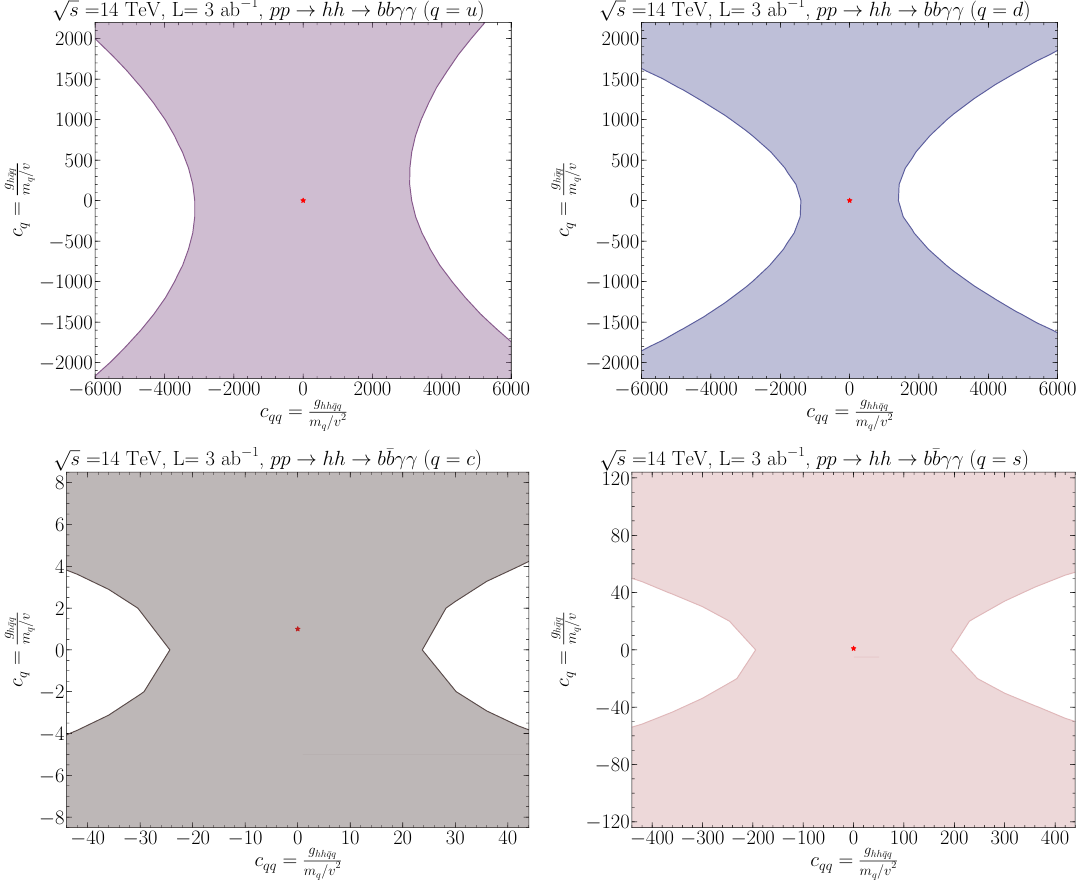
Figure 14 . 95% CL likelihood contours for the non-linear EFT Wilson coe(cid:14)cients c qq and c q for up ( upper left ), down ( upper right ), charm ( lower left ) and strange quarks ( lower right ).